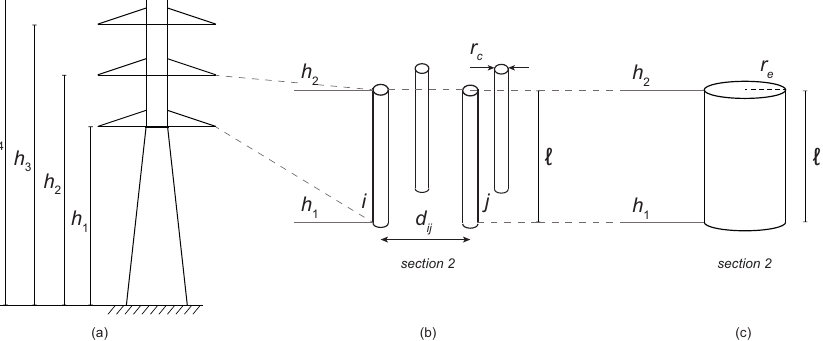
Figure 11. Set of four parallel vertical conductors to be modeled as an equivalent single conductor transmission line according to Ametani et al. [52]; ( a ) Transmission tower partitioned into sections; equivalent four-conductors system ( b ) and equivalent single-conductor model ( c ) of the considered section (section 2 in the